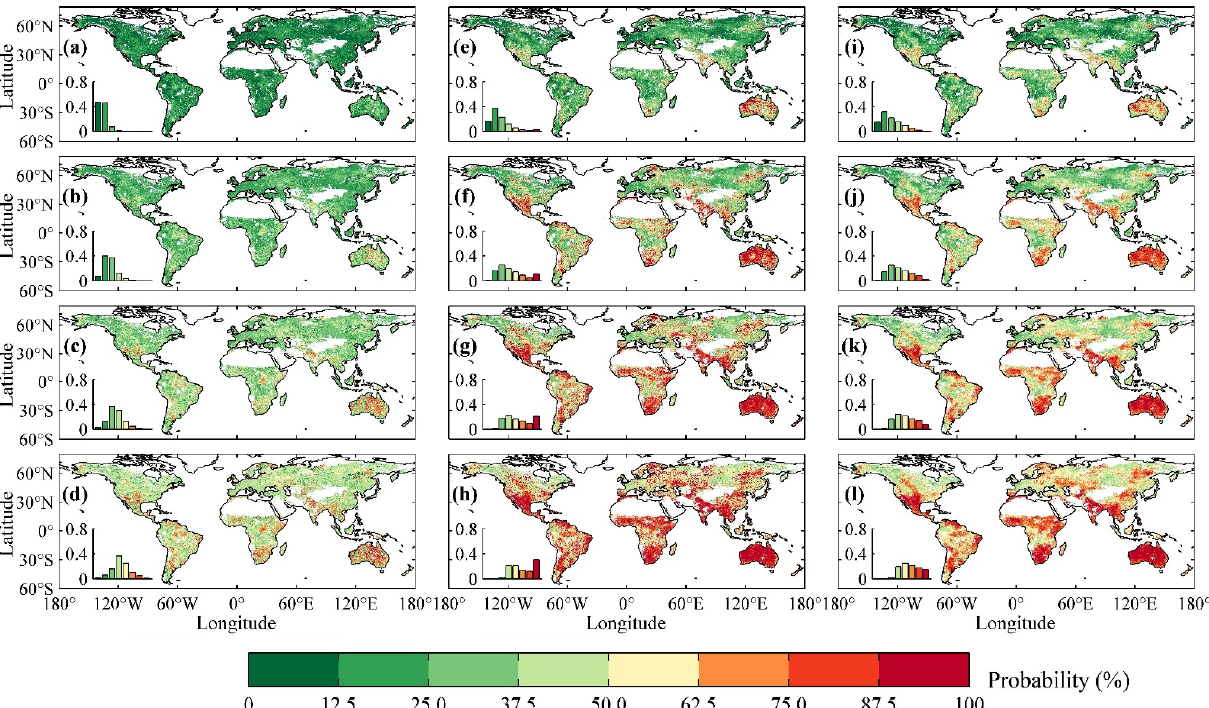
Figure 8. Conditional probabilities of vegetation productivity losses under different drought scenarios in March-May. ( a – d ) represent the conditional probabilities when the GPP ≤ 10 th , ≤ 20 th , ≤ 30 th , and ≤ 40 th percentiles in the moderate drought scenario, respectively. ( e – h ) represent the conditional probabilities when the GPP ≤ 10 th , ≤ 20 th , ≤ 30 th , and ≤ 40 th percentiles in the severe drought scenario, respectively. ( i – l ) represent the conditional probabilities when the GPP ≤ 10 th , ≤ 20 th , ≤ 30 th , and ≤ 40 th percentiles in the extreme drought scenario, respectively.